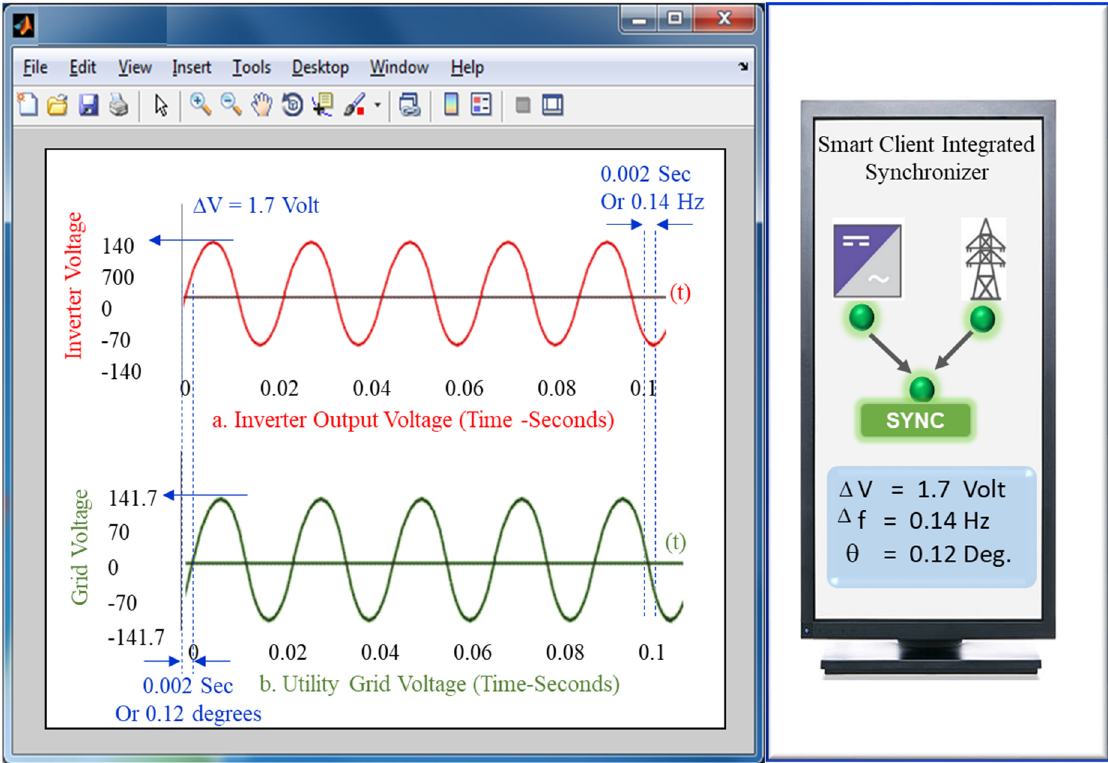
Figure 7. ( a ) Synchronization Process of Microgrid’s with Utility. ( b ) Smart Client Integrated Synchronizer.